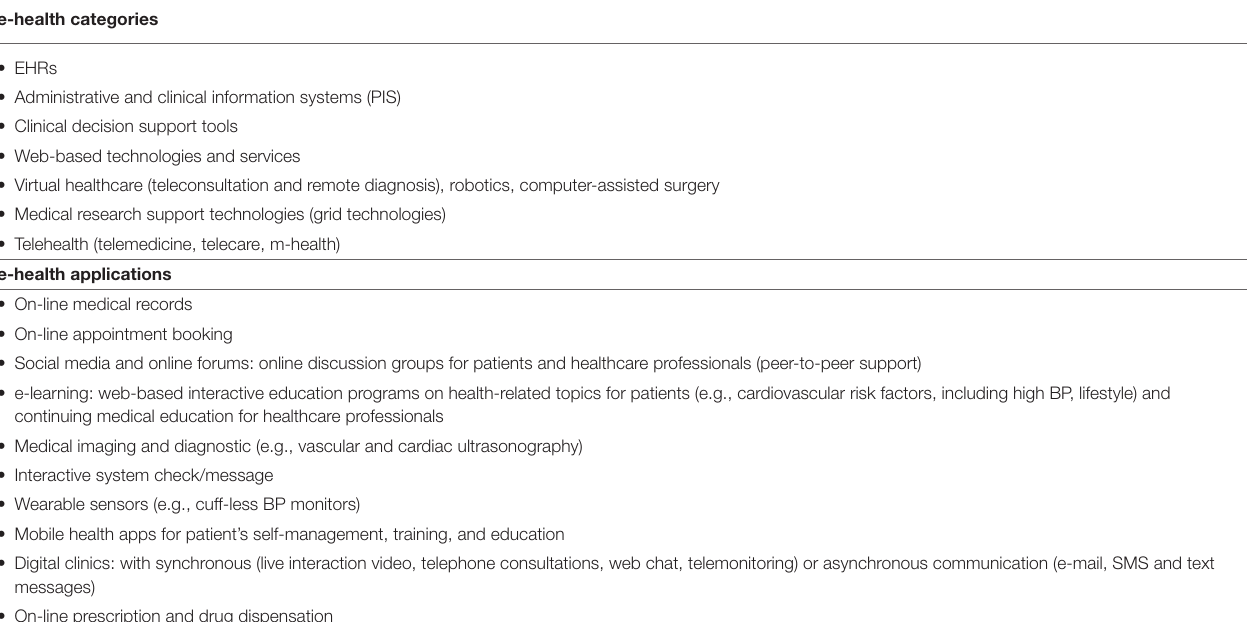
TABLE 1 | Main categories of e-health services and their practical